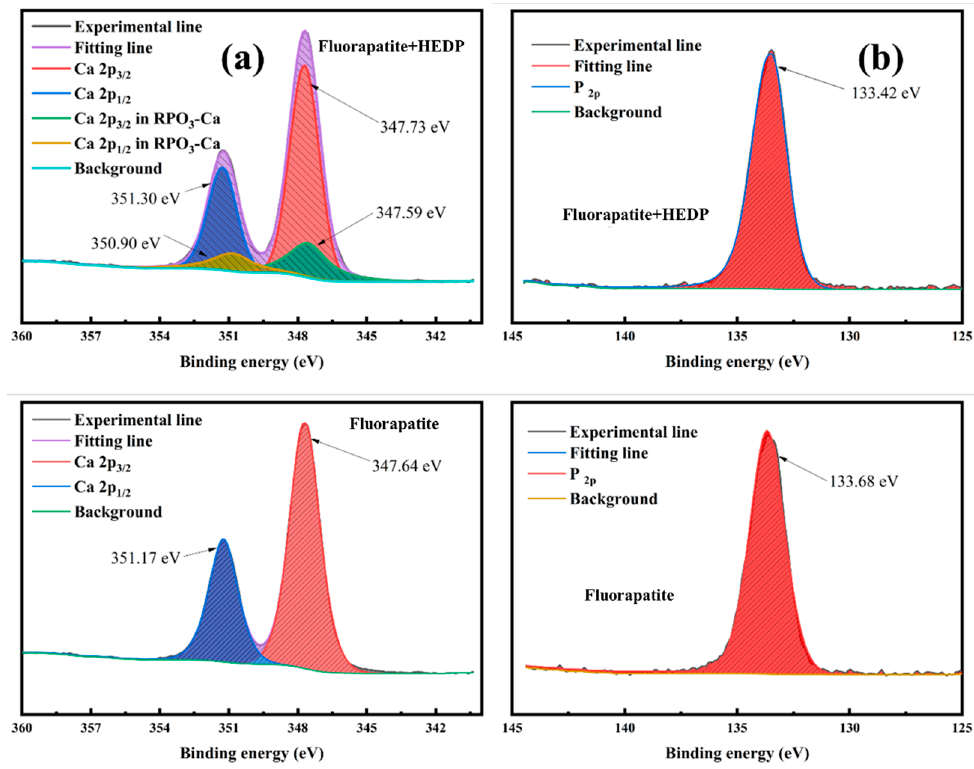
Figure 10. XPS spectra of Ca 2p ( a ) and P 2p ( b ) for fluorapatite before and after the interaction with HEDP.